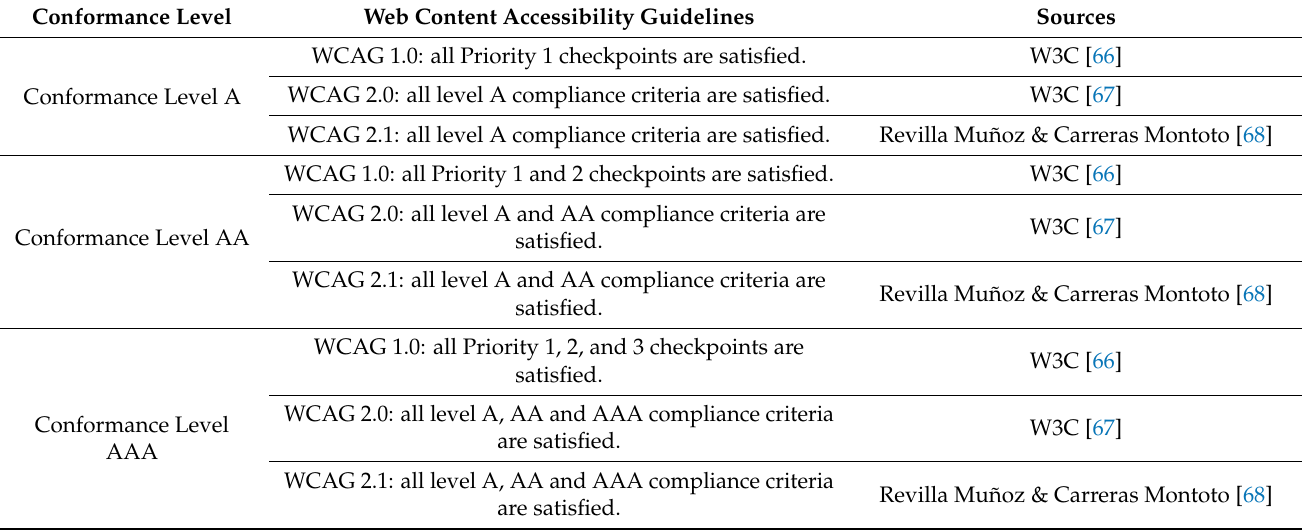
Table A5. Suitability levels according to the level of compliance (A, double A or triple